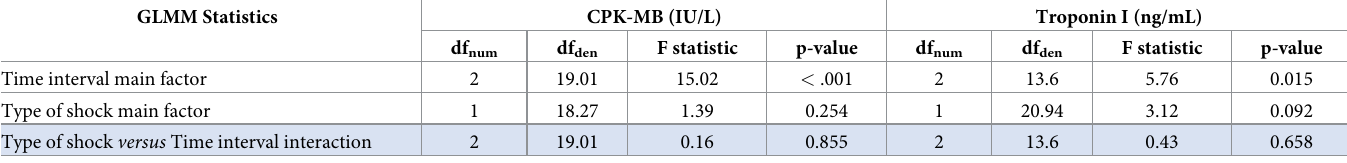
Table 4. General Linear Mixed Model analysis for Animal Study #3 biomarker levels. GLMM Statistics